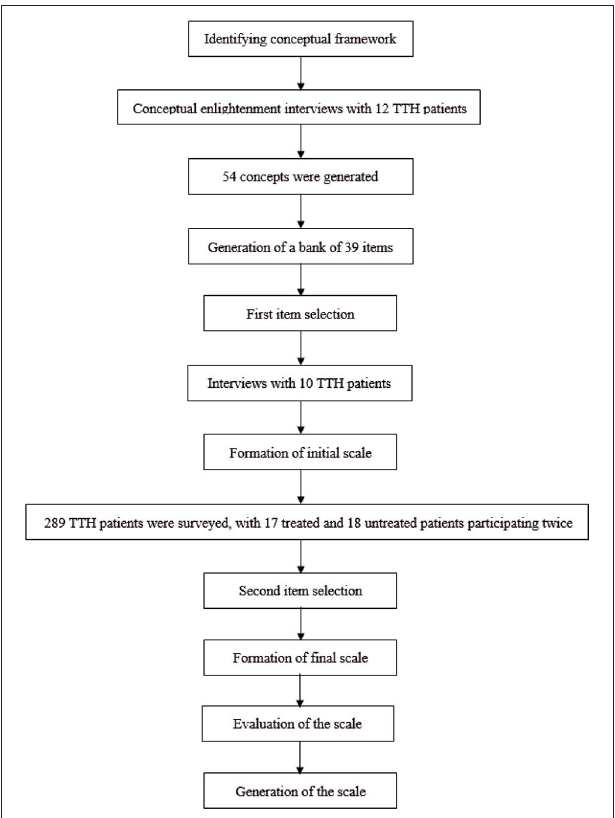
FIGURE 1 | Flowchart of the scale developmental